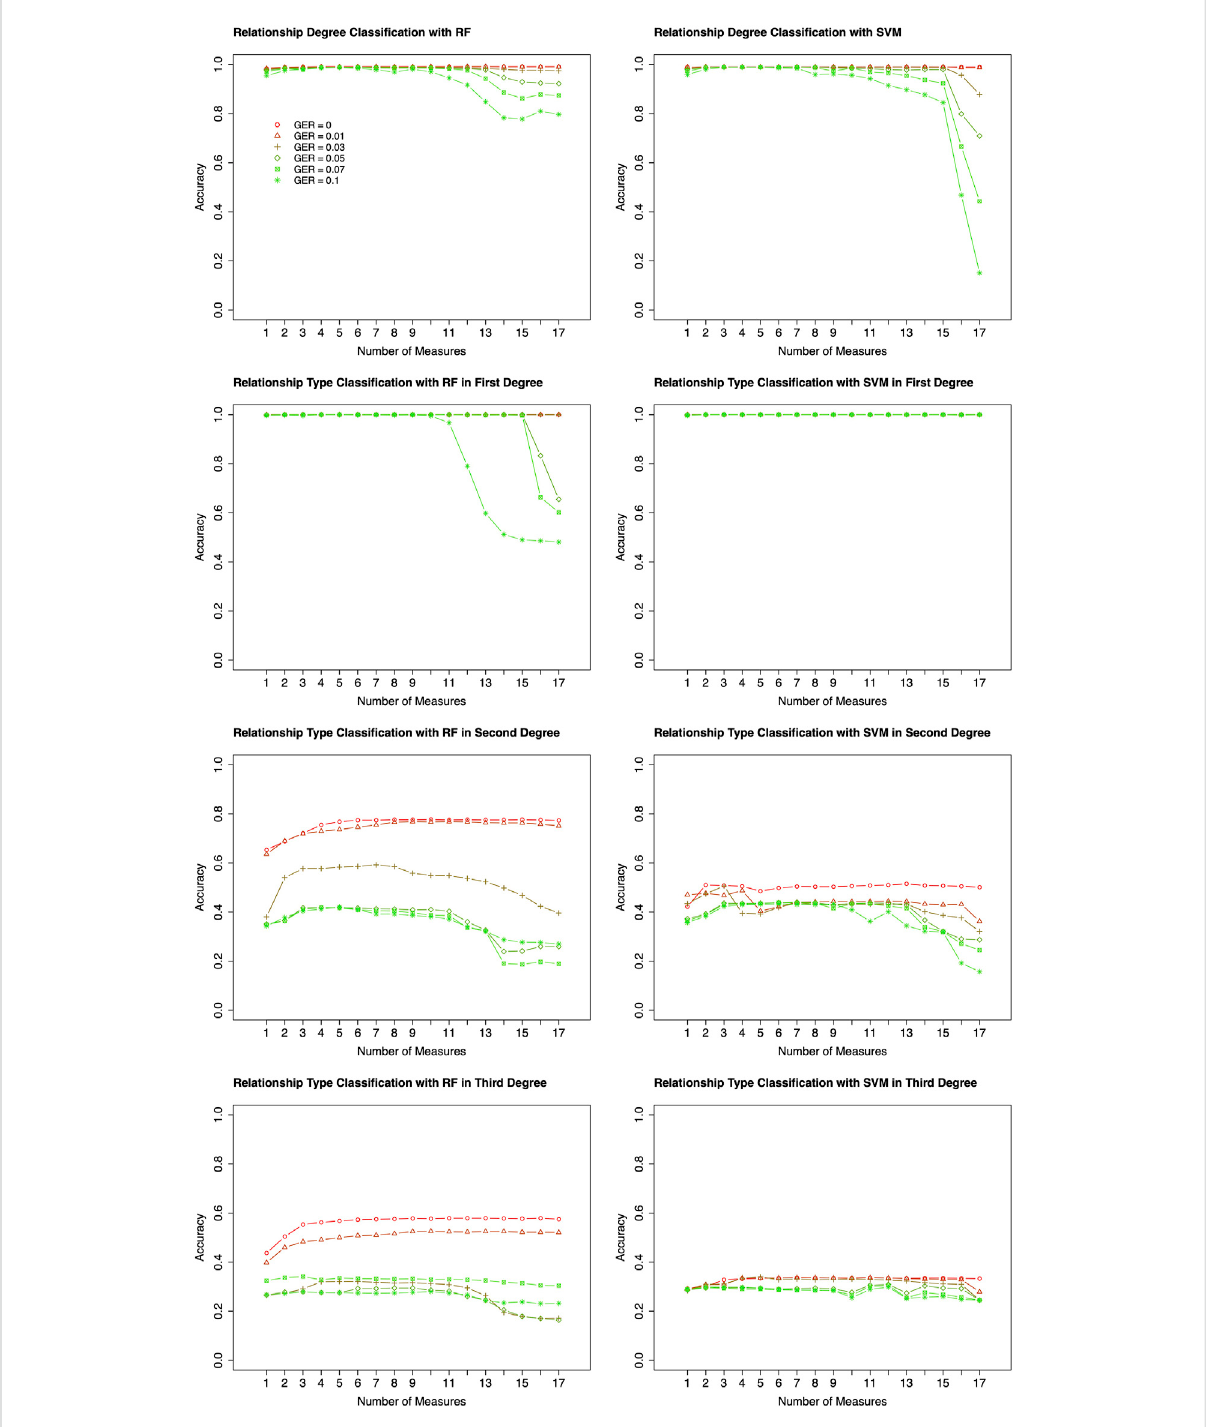
FIGURE 3 Classi fi cation algorithm comparisons between Random Forest (RF) and Support Vector Machine (SVM). Two algorithms (left four plots for RF; rightfourplotsforSVM)wereemployedtoconductforwardfeatureselectionwith10-foldcross-validationforrelationshipdegree,relationshiptypes within the 1st degree, relationship types within the 2nd degree, and relationship types within the 3rd degree. Different genotyping error rates were presented with different colors. The x -axis is the number of selected measures (or features) in each step of the forward selection. GER = genotyping error rate of the test